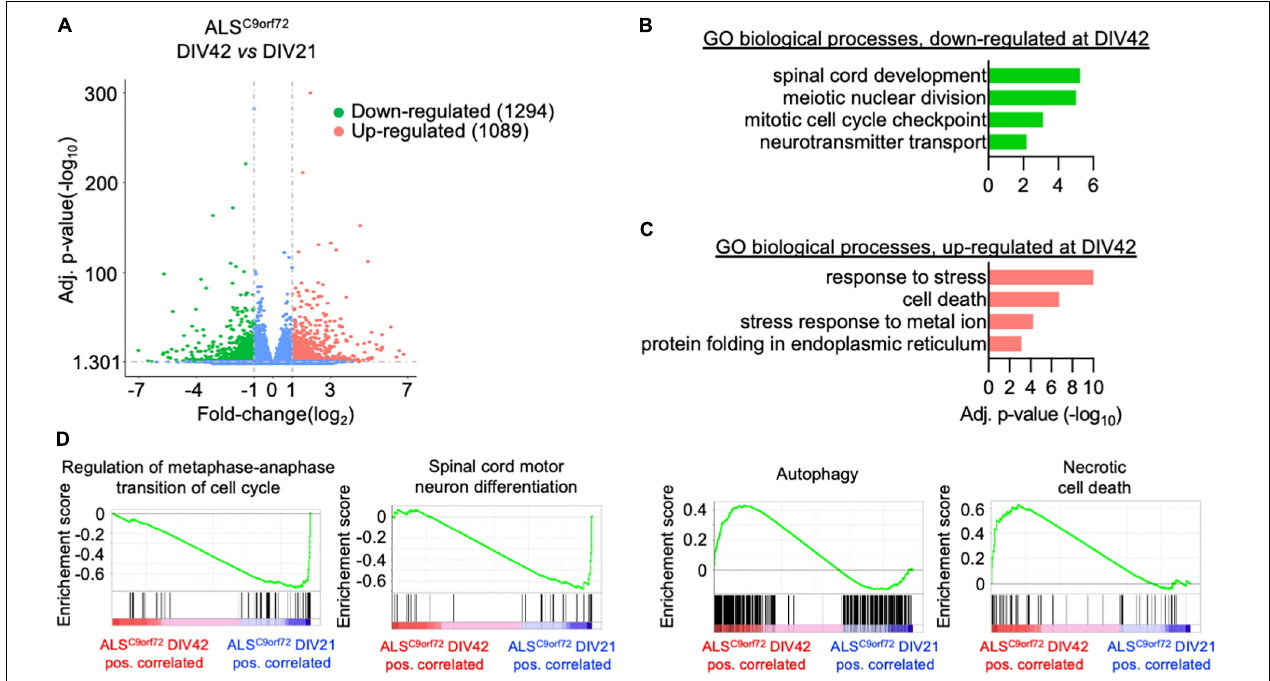
FIGURE 4 | Longitudinal analysis of the ALS C9orf72 transcriptome highlights increased neuronal sufferance and reduced synaptic transcripts. (A) Volcano plot displaying the DEGs detected in ALS C9orf72 MN upon aging. (B) Representative GO biological pathways significantly down- or (C) up-regulated at DIV42 when compared to DIV21 cultures. (D) GSEA showing enriched correlation of pathways involved in cellular division and spinal cord development with DIV21 MN, while autophagy and cell death are strongly correlated to aged